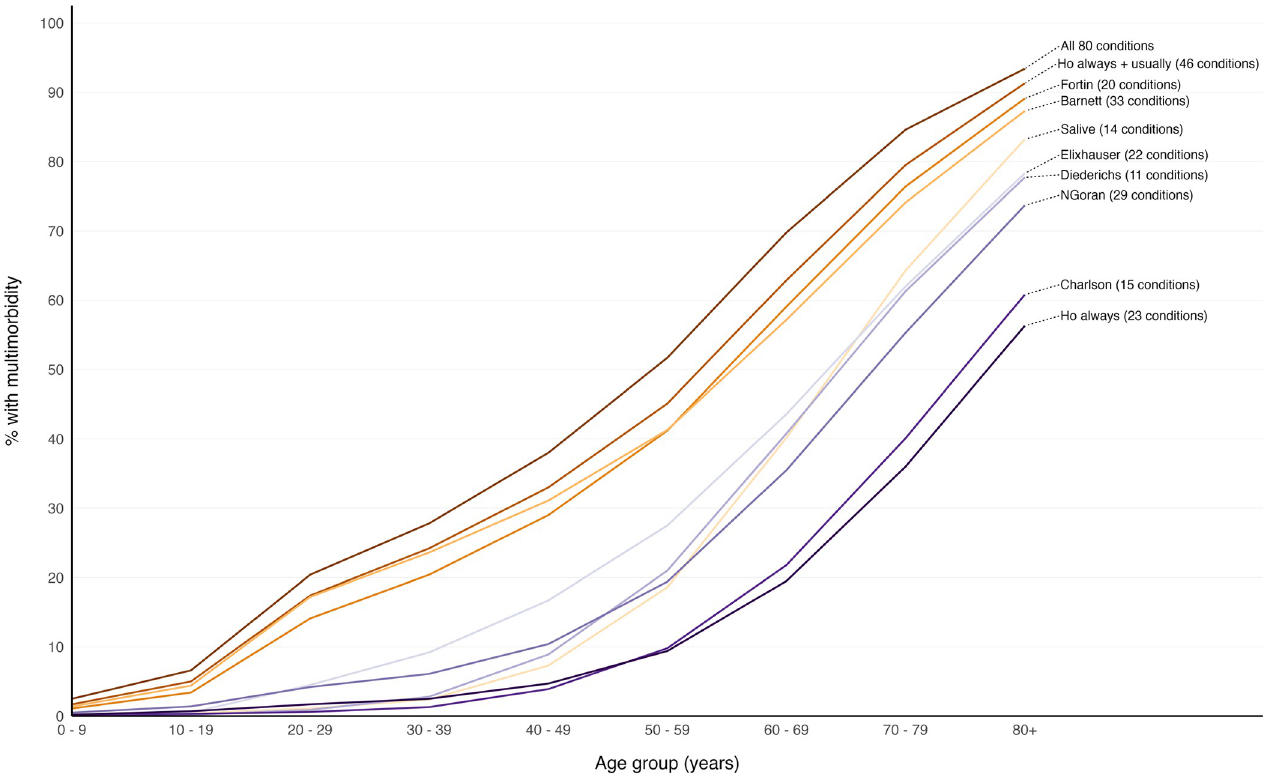
Fig 5. Multimorbidity prevalence by age considering all 80 conditions and according to existing condition-lists. Labelled coloured lines represent multimorbidity prevalence calculated for each age group when considering conditions in each condition-list.